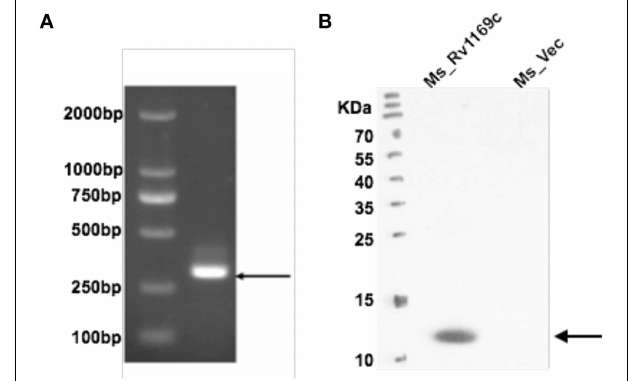
FIGURE 1 | Heterologous expression of M. tuberculosis Rv1169c in M. smegmatis . (A) Ms_Vec and Ms_Rv1169c were grown into an OD 600 of 0.8 and then were subjected to PCR amplification to detect Rv1169c gene. (B) The cell lysates were prepared from acetamide-induced Ms_Vec and Ms_Rv1169c were subjected to Western blot to determine the expression of His-tagged Rv1169c protein in M. smegmatis by mouse anti-His antibody.